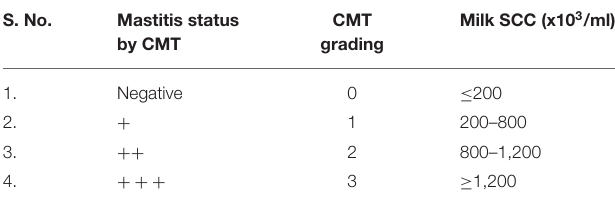
TABLE 2 | Grading of milk-based on the CMT and